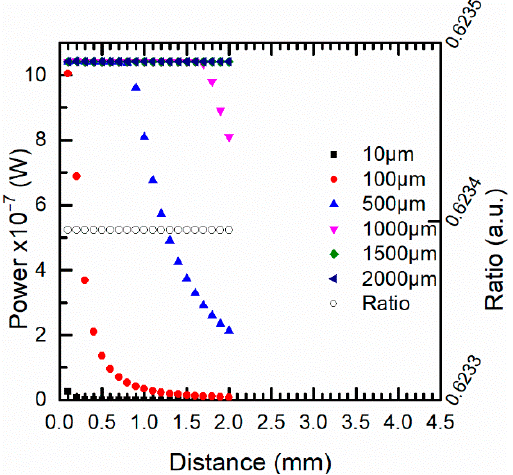
Figure 12. Effect of the target size in the energy recovered at 1000 °C by the 1310 nm channel for different distances. Right y-axis ratio (1310/1550 nm) (unfilled markers) for the different target sizes.